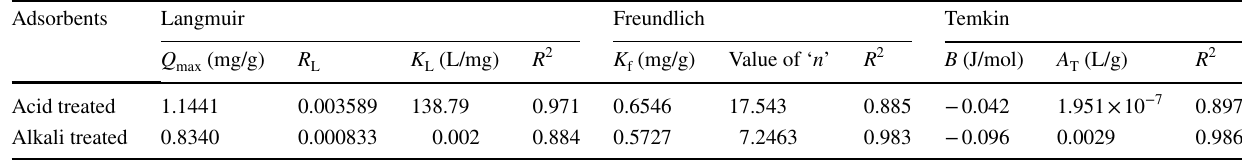
Table 5 Langmuir, Freundlich and Temkin equation values for adsorption of fluoride with respect to initial fluoride ion concentration Adsorbents